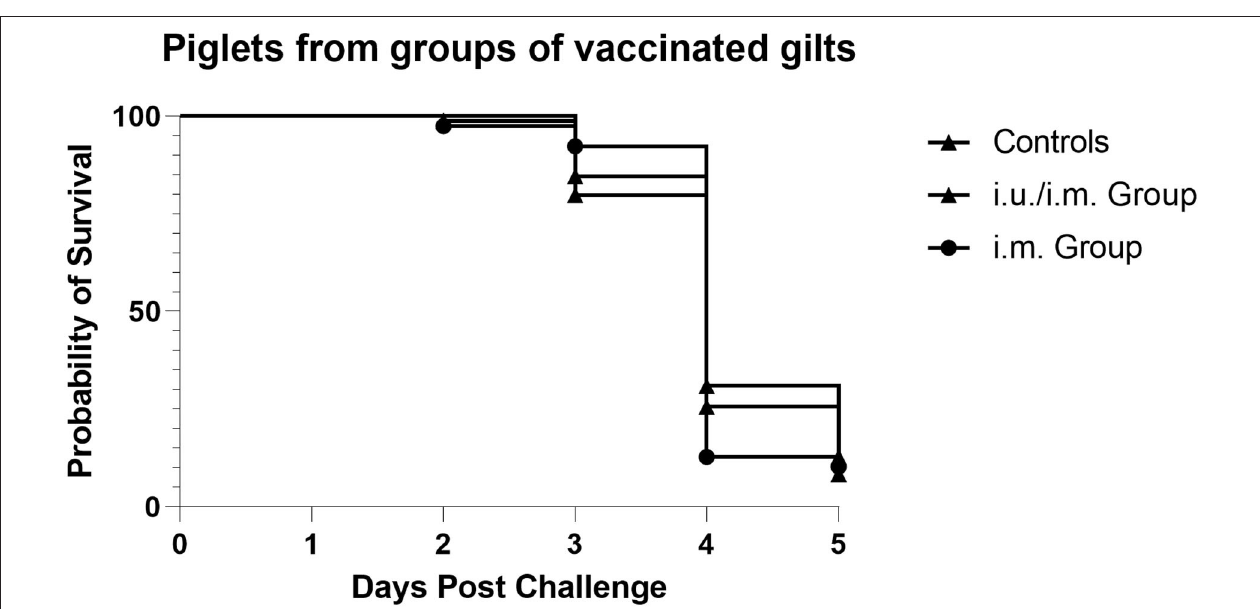
FIGURE 4 | Survival of piglets when challenged with infectious PEDV 3 days after birth. The majority of the piglets born from negative control gilts and piglets born from i.m. vaccinated gilts and i.u./i.m. vaccinated gilts were euthanized on day 4 when their cumulative depression and weight loss scores reached a score of 4.